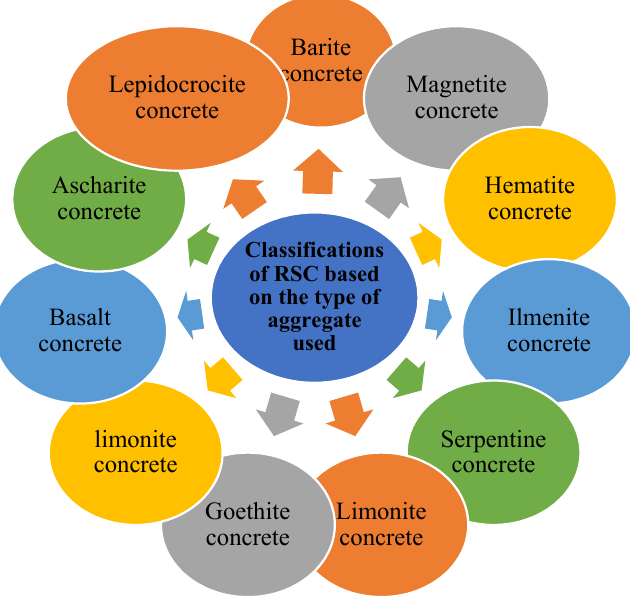
Figure 2. Classifications of RSC (Adapted with improvements from [21]).